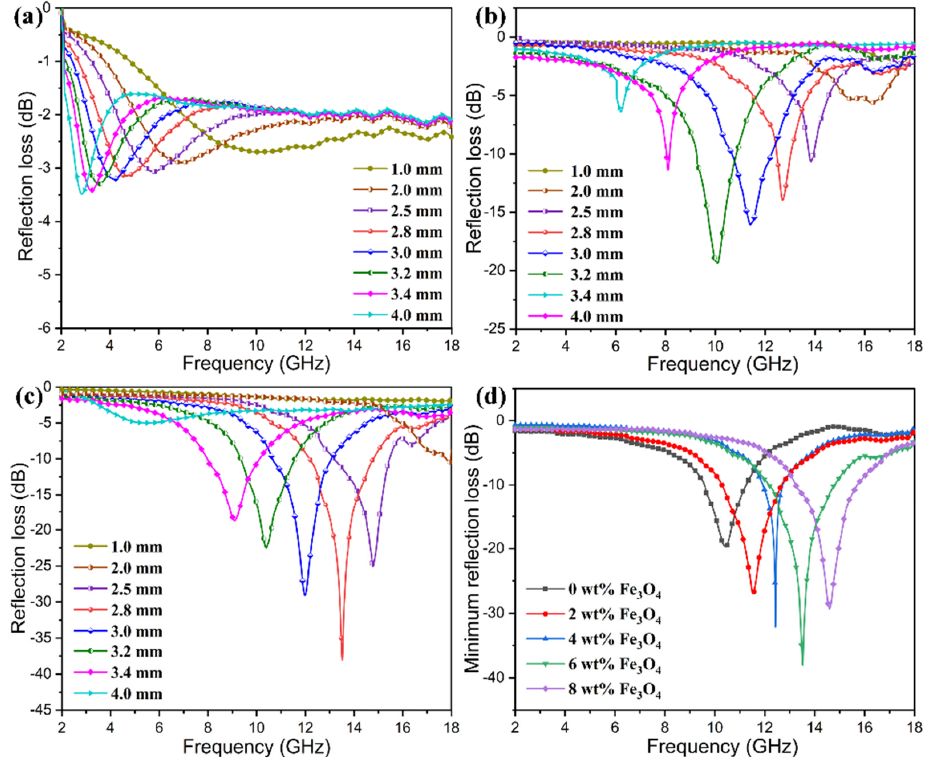
Figure 19. Plots of reflection loss as a function of frequency for ( a ) the PI aerogel/PEG composite film, ( b ) the PI/graphene aerogel/PEG composite film containing 5 wt% graphene nanosheets, and ( c ) PI/graphene/Fe 3 O 4 hybrid aerogel/PEG composite films containing 5 wt% graphene nanosheets and 6 wt% Fe 3 O 4 nanoparticles at different film thicknesses. ( d ) Plots of minimum reflection loss as a function of frequency for the PI/graphene/Fe 3 O 4 hybrid aerogel/PEG composite films containing 5 wt% graphene nanosheets at different contents of Fe 3 O 4 nanoparticles.